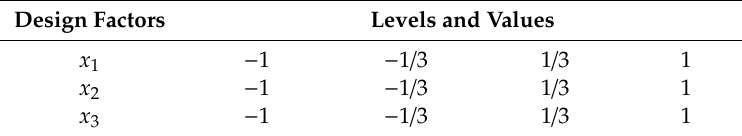
Table 1. Design factors and